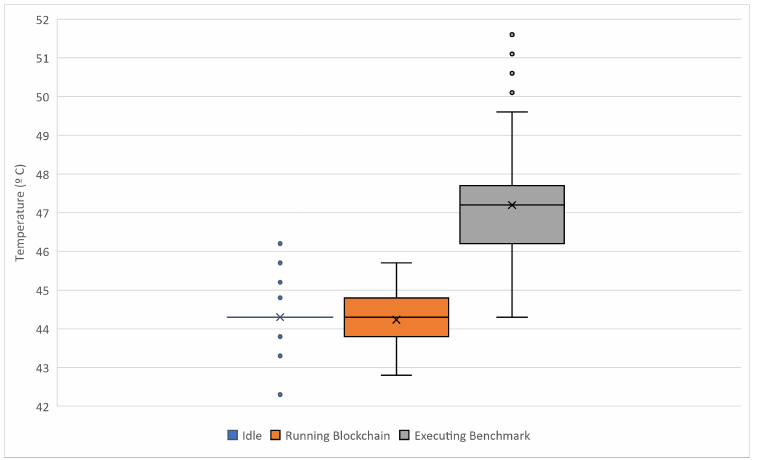
Figure 10. RPi3 CPU temperatures in different